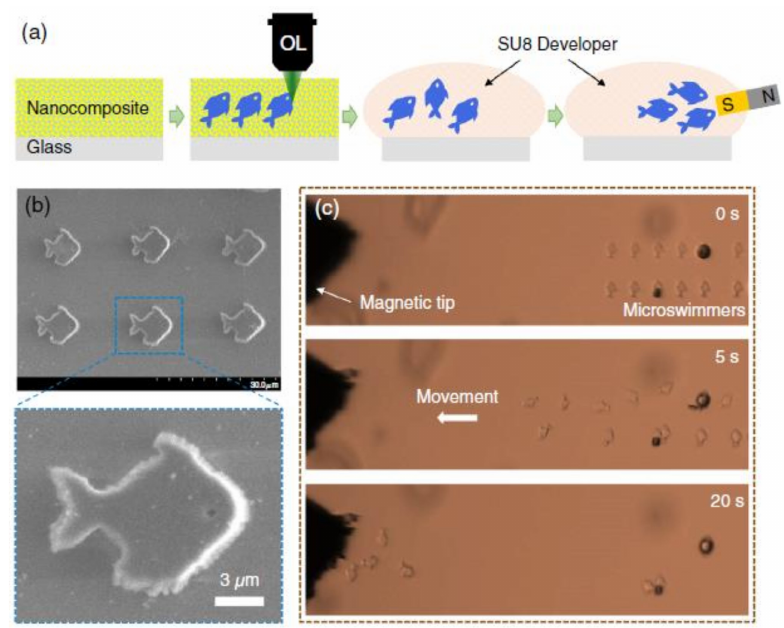
Figure 19. ( a ) Schematic of the fabrication of micro-swimmer by DLW and its magnetic drive; ( b ) the SEM image of micro-simulators; and ( c ) the response of the micro-simulators to external magnetic field